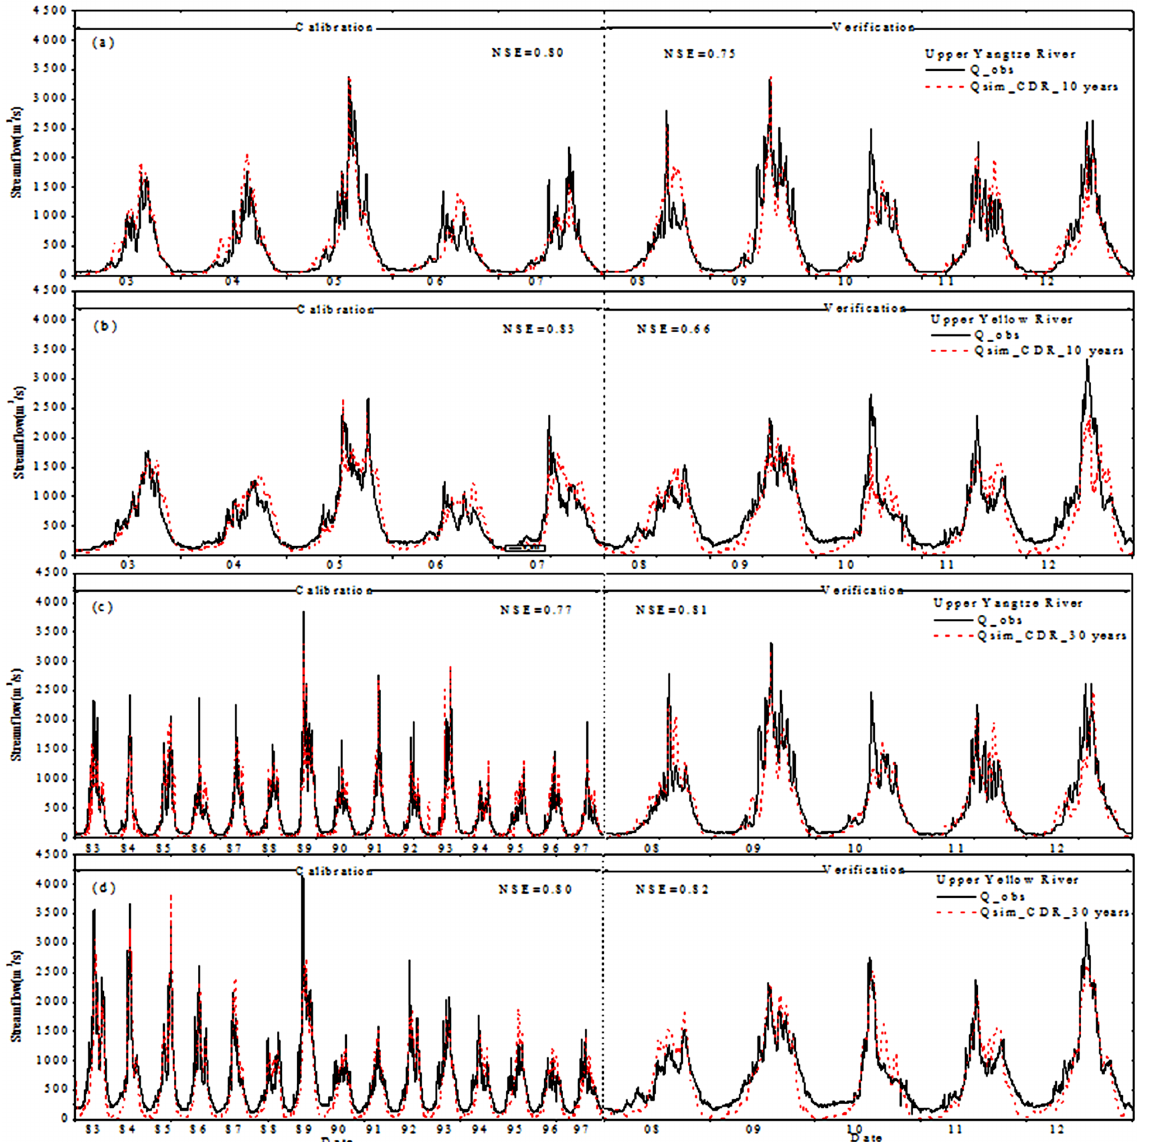
Figure 7. The simulated daily streamflow (red) forced by PERSIANN-CDR rainfall product in different scenarios and the observed daily streamflow (black) at the outlets of the upper Yangtze River basin and upper Yellow River basin. Panels (a) and (b) are the scenarios where the period 2003 to 2007 is used for calibration and 2008 to 2012 for verification. Panels (c) and (d) are the scenarios where the period 1983 to 1997 is used for calibration and 2008 to 2012 for